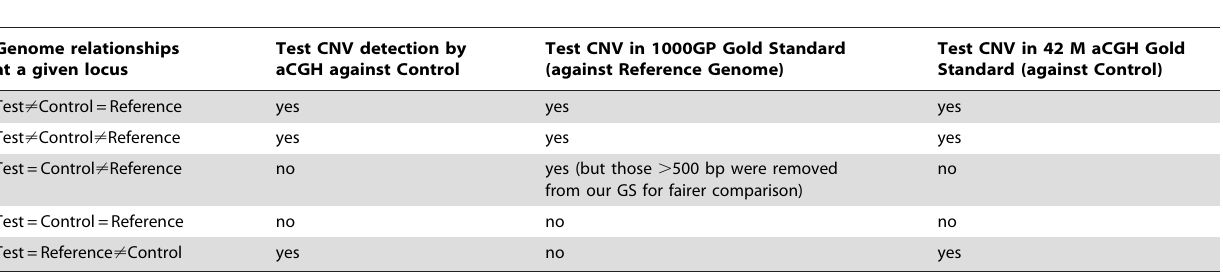
Table 2. Summary of possible relationships between reference, experimental control and test genomes and the resulting abilities of different methods to detect CNVs in the test genome (with respect to the reference genome).